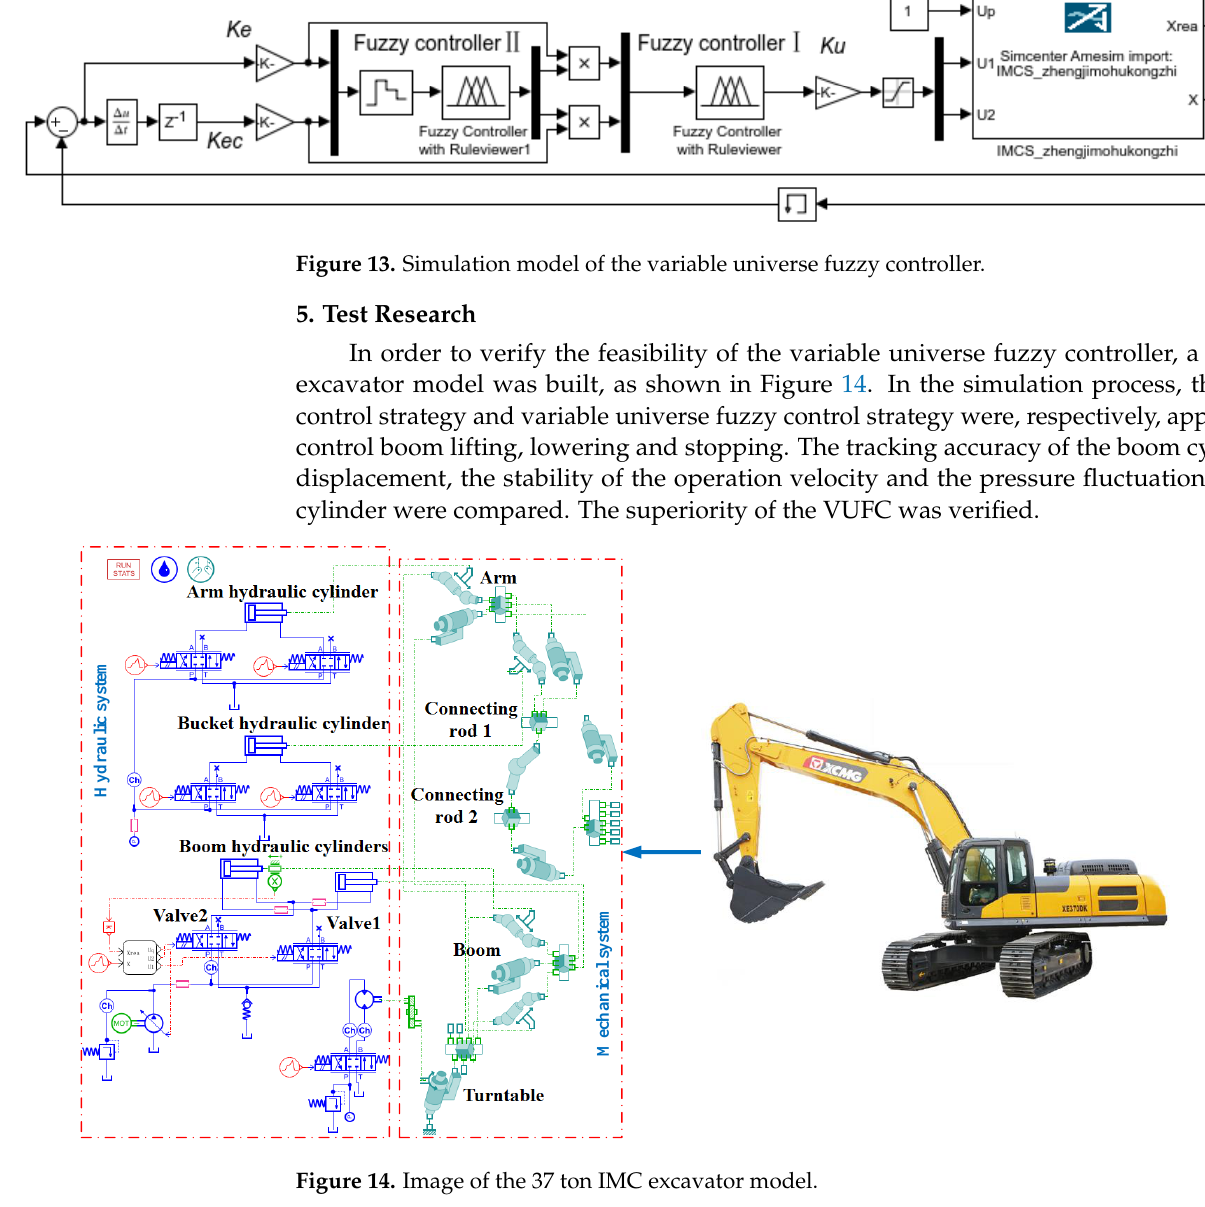
 . ( b ) Mapping of input variables to 1